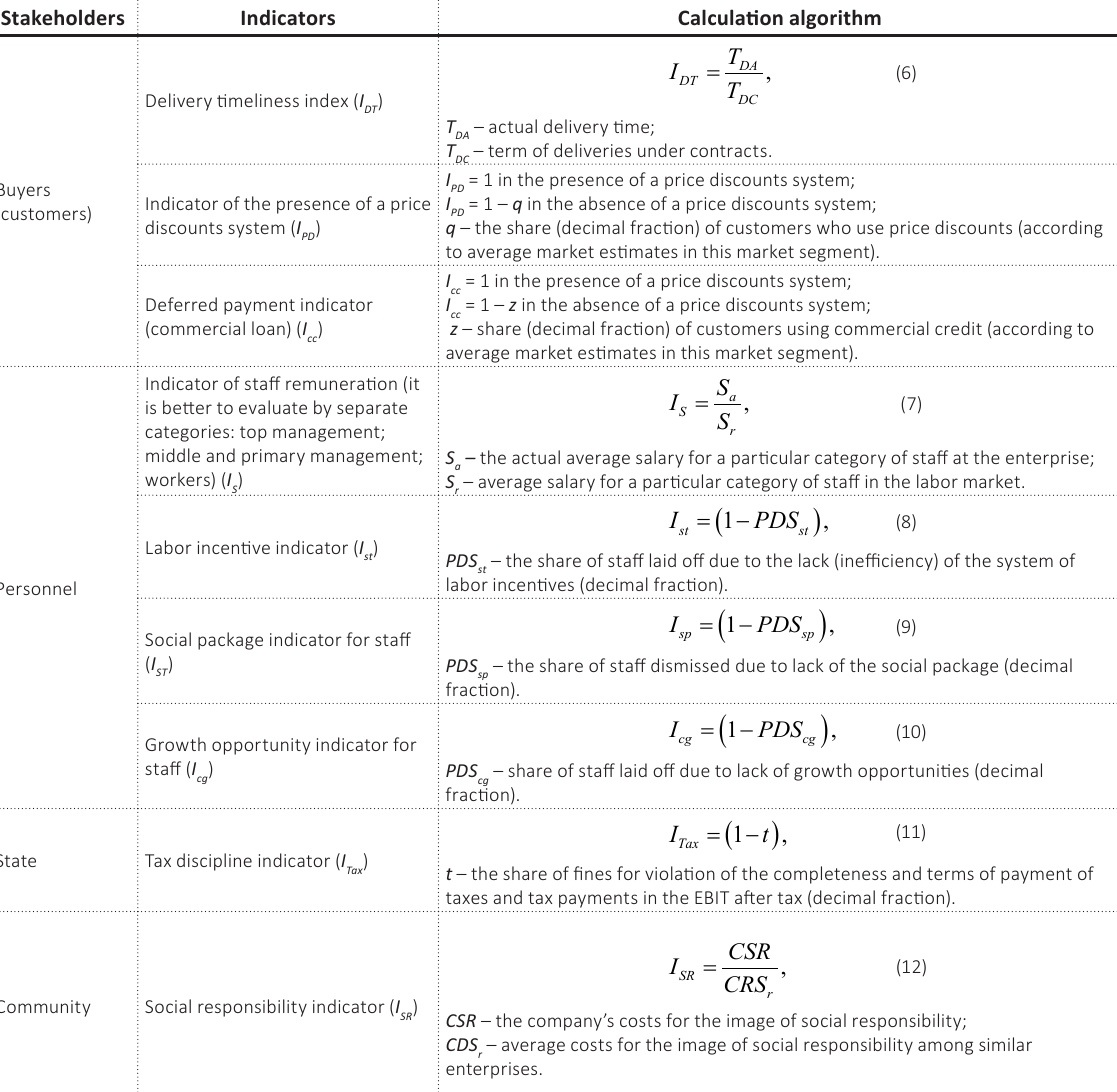
Table 2 (cont.). Personalized performance indicators that reflect the financial interests of